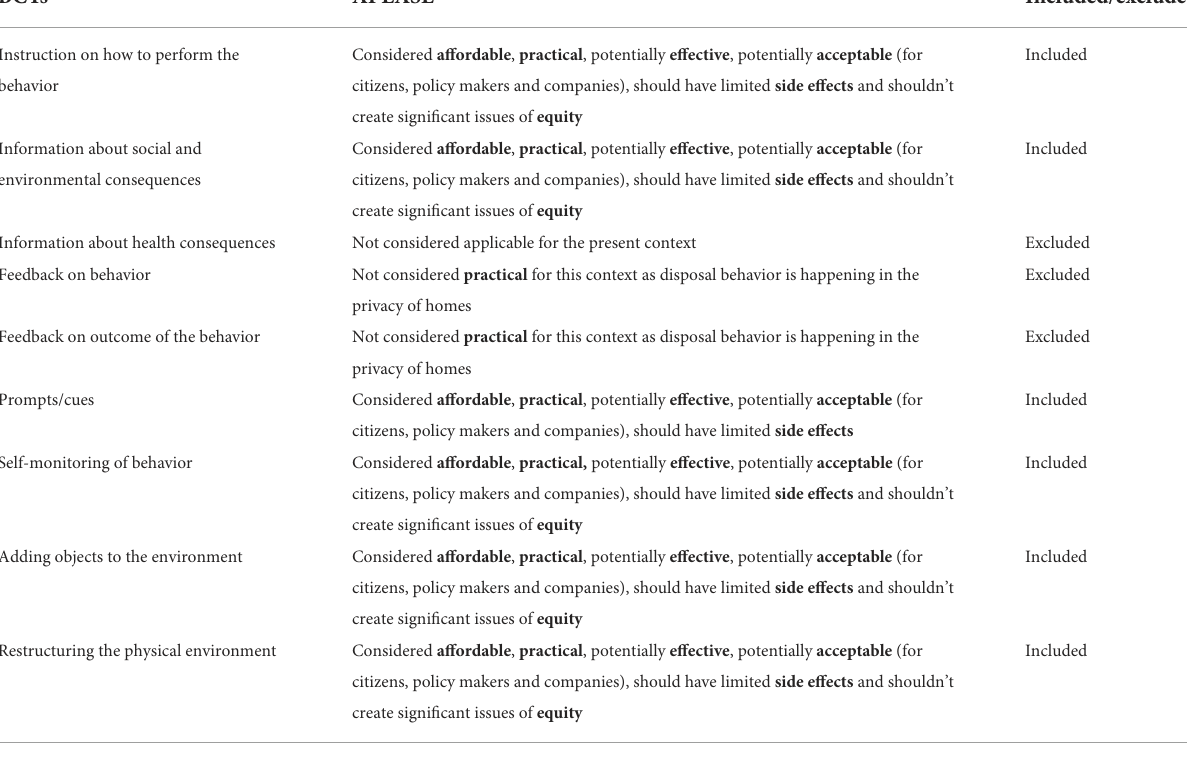
TABLE 5 List of included/excluded BCTs with reasons for inclusion/exclusion.